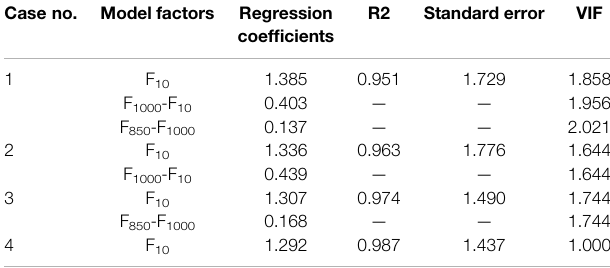
TABLE 2 | Model overview. Case no. Model factors Regression